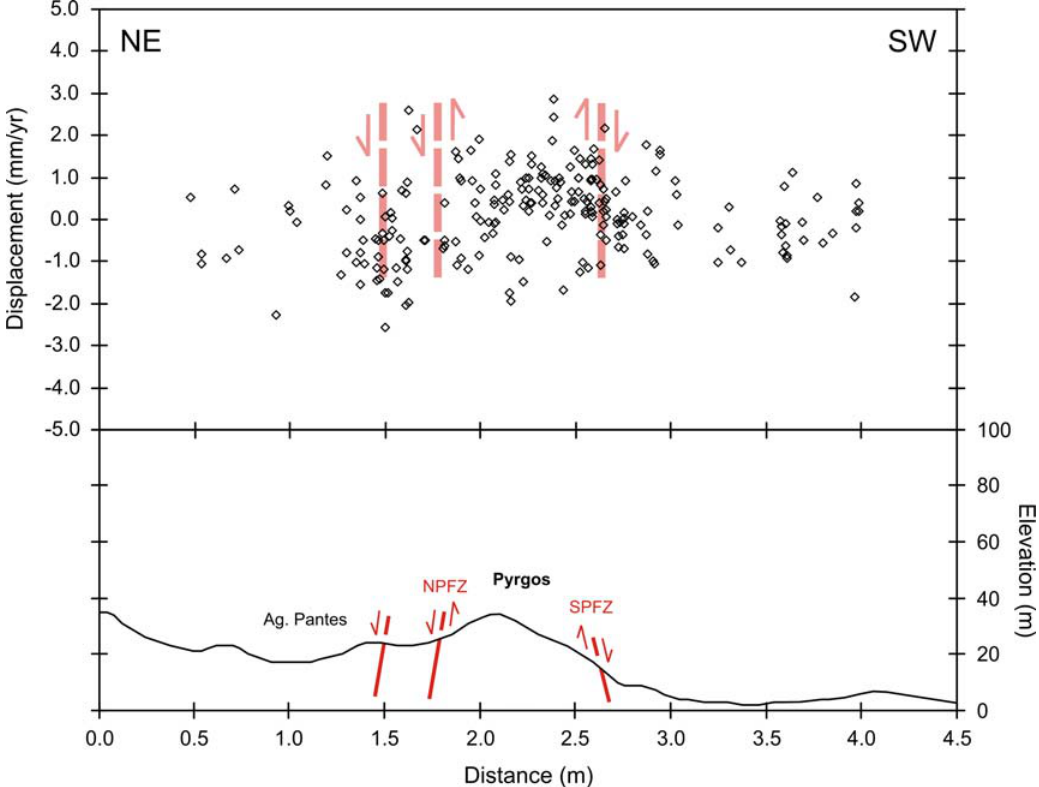
Figure 10. Spatial profile showing the displacement field as observed by IPTA and plotting targets within 150 meters in both sides of the profile (upper), and the related topography (down), red lines correspond to the